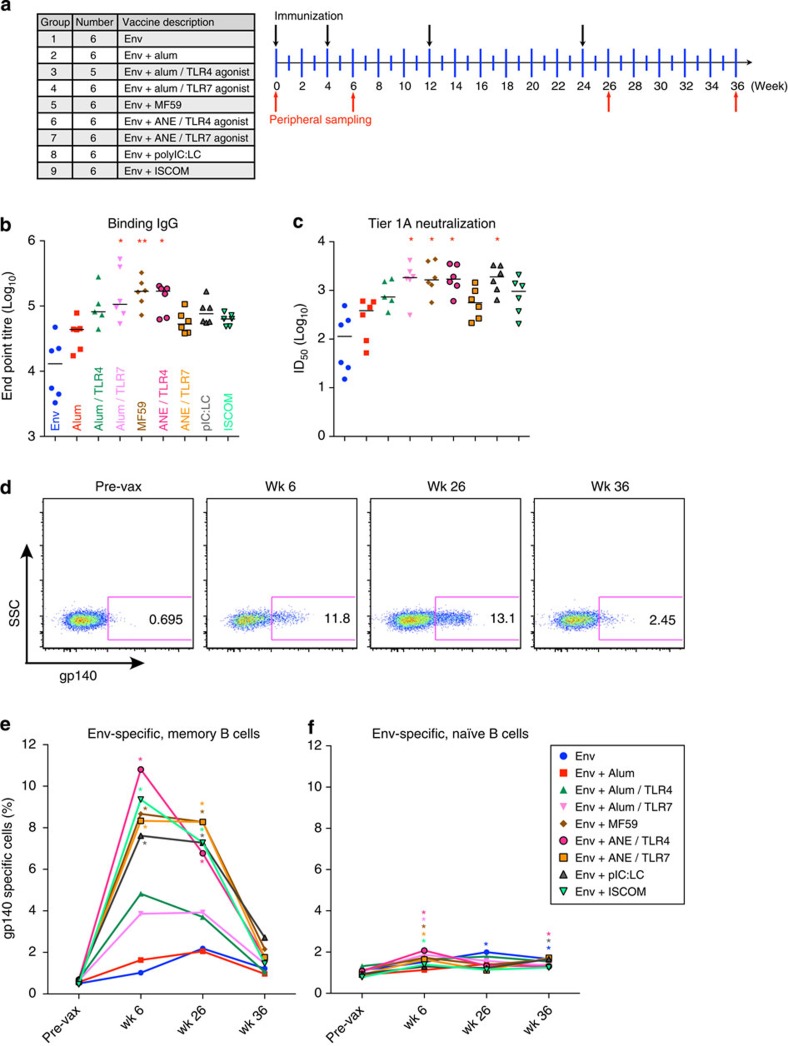
Vaccination with adjuvants results differential effects on humoral and B cellular responses.(a) Vaccination project overview. Nine vaccines were given to 53 NHP in a homologous prime-boost manner at 0, 4, 12 and 24 weeks (black arrows). PBMC sampling was performed before vaccination (pre-vax) and 6, 26 or 36 weeks after the prime (red arrows). (b) Env-specific IgG-binding titres at week 26. (c) Plasma neutralization of tier 1A MW965.26 Env-bearing pseudovirus at week 26. Horizontal bars indicate medians. *P<0.05; **P<0.01 compared with Env+alum group by the Kruskal–Wallis test. (d–f) Antigen-specific B cells were identified from PBMCs at the indicated time points by binding to a gp140 protein probe followed by flow cytometry. (d) Representative flow cytometry plots of antigen-specific memory B cells at the indicated time points after prime. Antigen-specific memory (e) or naive (f) cells were enumerated at the indicated time points. Data points represent vaccine group means and are depicted as a percent of all IgG+ cells. *P<0.05 compared with pre-time point by two-way analyses of variance.